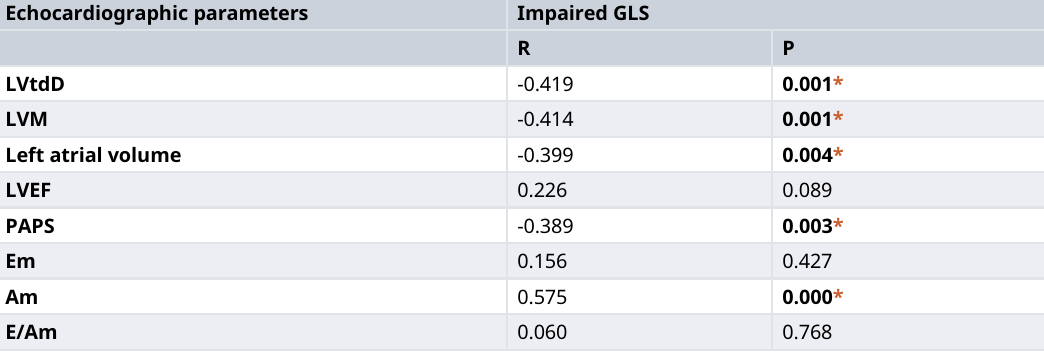
Table 4. Echocardiographic parameters according to impaired LVGLS in sickle cell anemia patients. Echocardiographic